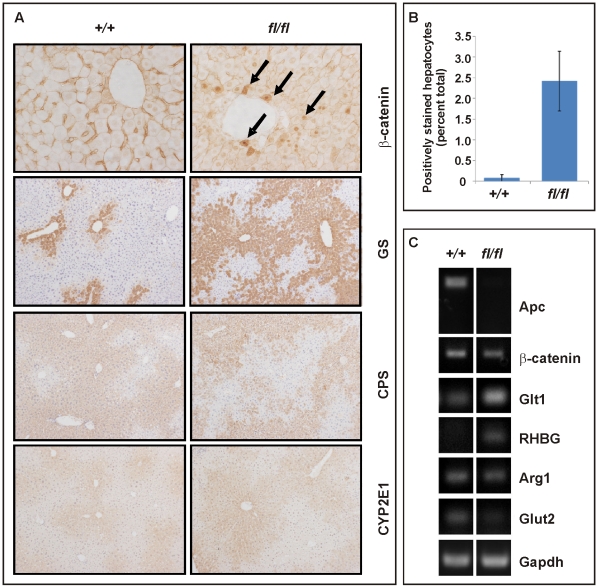
Liver zonation is affected in hypomorphic Apcfl/fl mutant mice.(A) Immunohistochemical expression analysis for β-catenin, glutamine synthetase (GS), carbamoylphosphate synthetase (CPS) and Cyp2E1 was performed on livers of age-matched wild-type (+/+) and (fl/fl) mice. Arrows point to nuclear β-catenin staining. (B) Hepatocytes with nuclear β-catenin staining were expressed as a percentage of total hepatocytes scored in age-matched wild-type (+/+; n = 3) and (fl/fl; n = 4) mice. p = 0.025 (Mann-Whitney). (C) Semi-quantitative RT-PCR analysis from liver of 5mo old healthy (+/+) and (fl/fl) mice for assessment of expression of Apc, CtnnB1, along with the perivenous markers Glt1 (encoding a transporter of glutamate), RHBG (encoding the ammonium transporter), and the periportal markers Arg1 (encoding arginase1) and Glut2 (encoding glutaminase 2). Gapdh serves a as an RT-PCR amplification control.